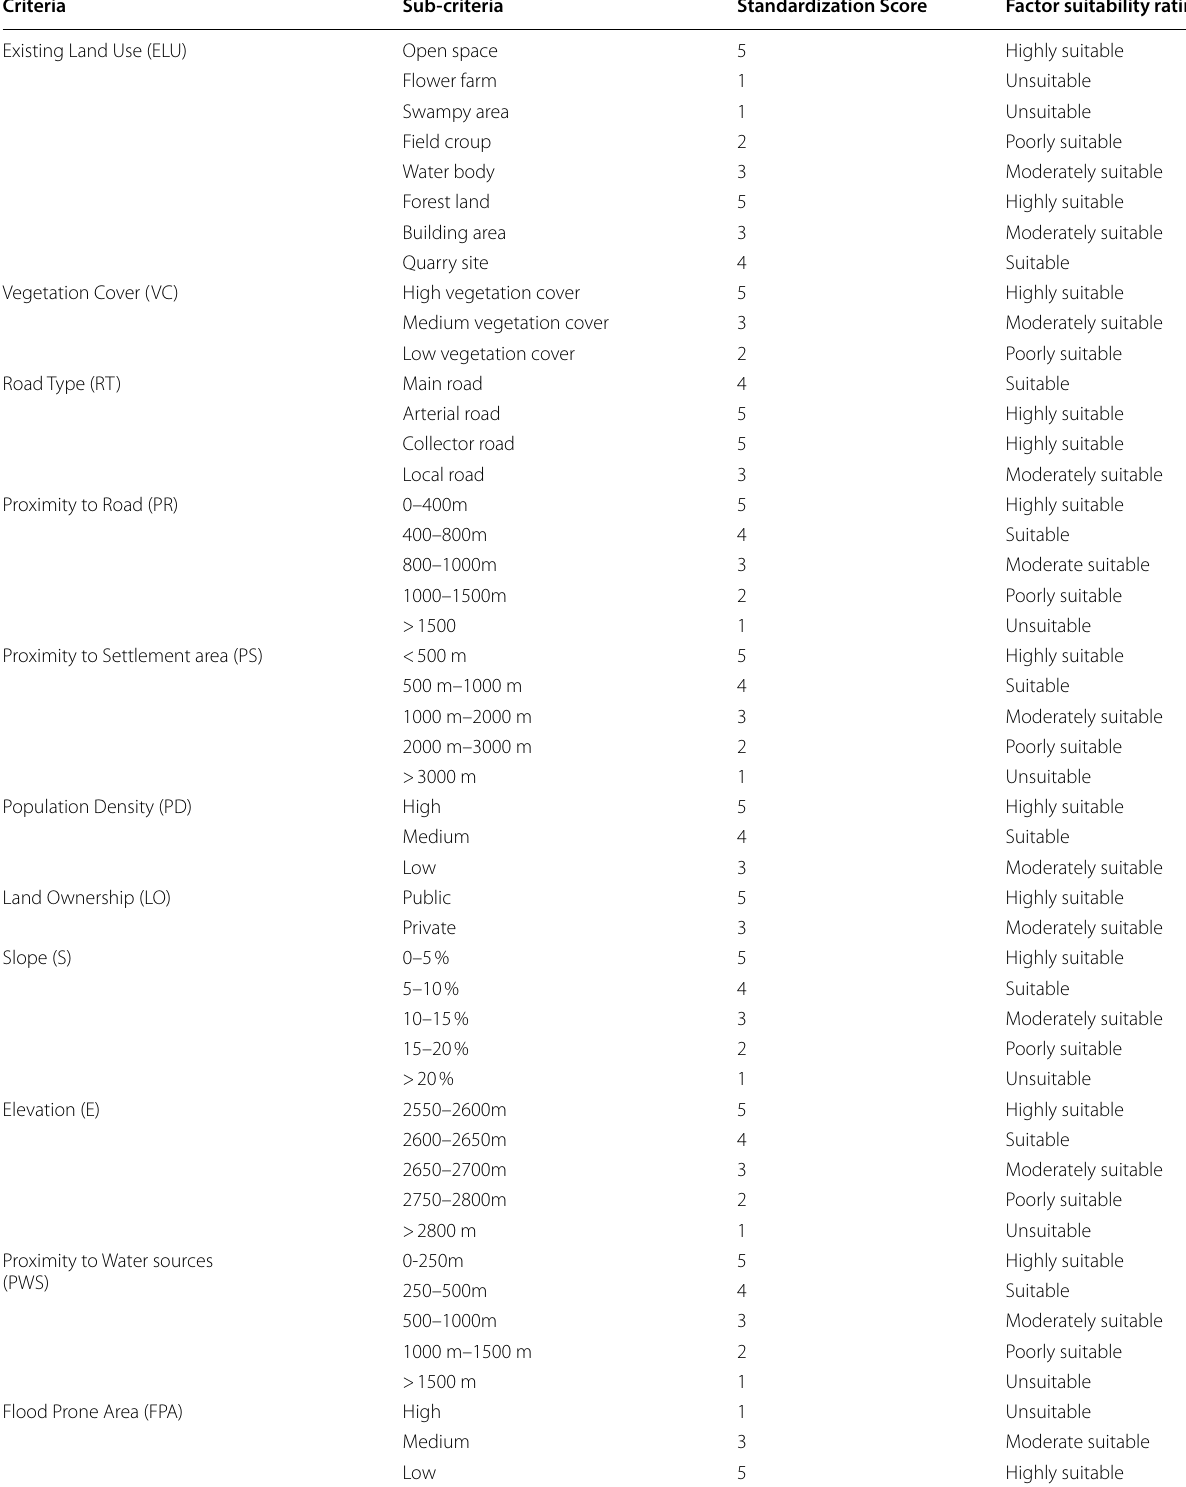
Table 2 Criteria and sub-criteria for suitability